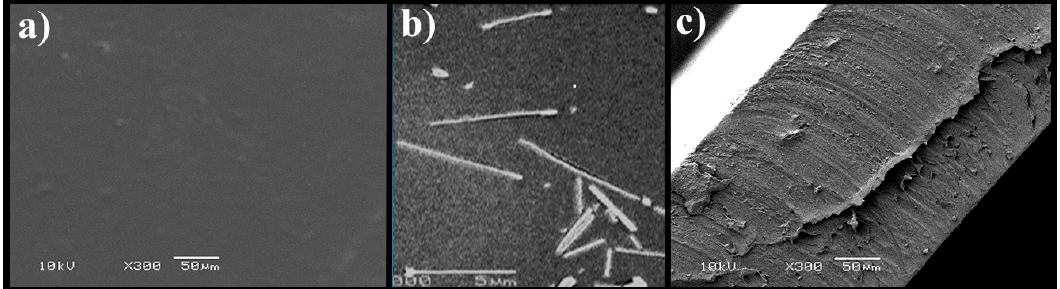
Figure 6. SEM images of ( a ) the surface of the undoped membrane and of ( b ) the surface and ( c ) the